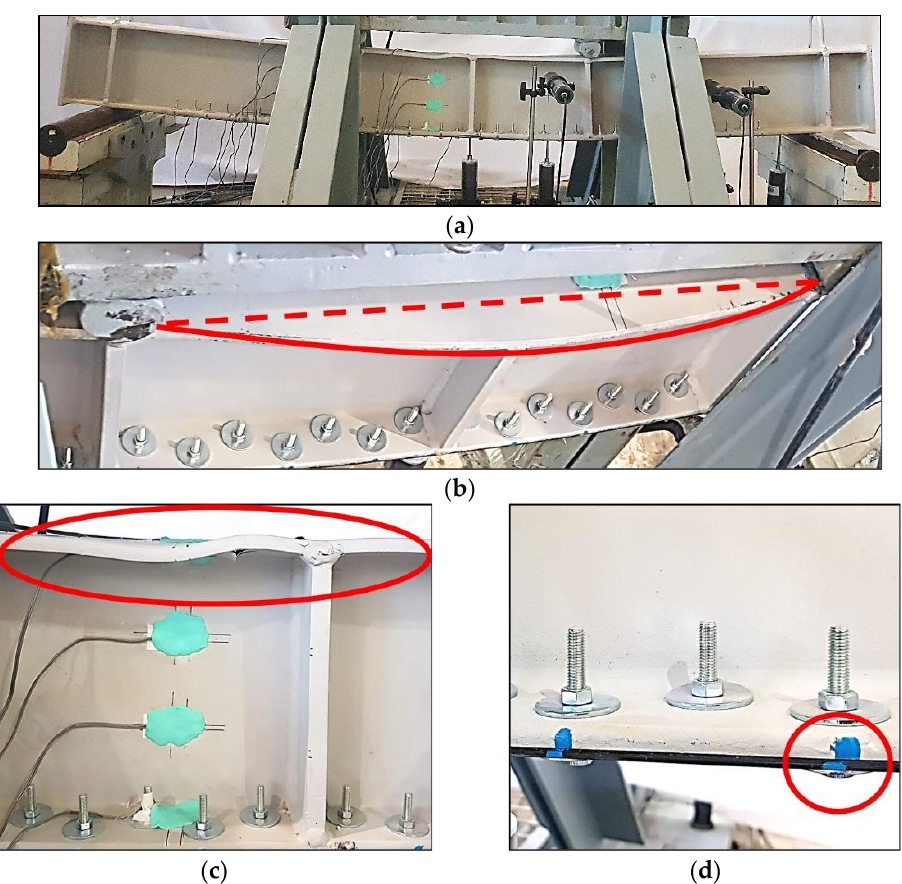
Figure 9. Sample photos of the observed failure modes of the strengthened beams: ( a ) excessive deflection; ( b ) lateral torsional buckling; ( c ) flange local buckling; ( d ) bolt bearing against the HFRP strip.